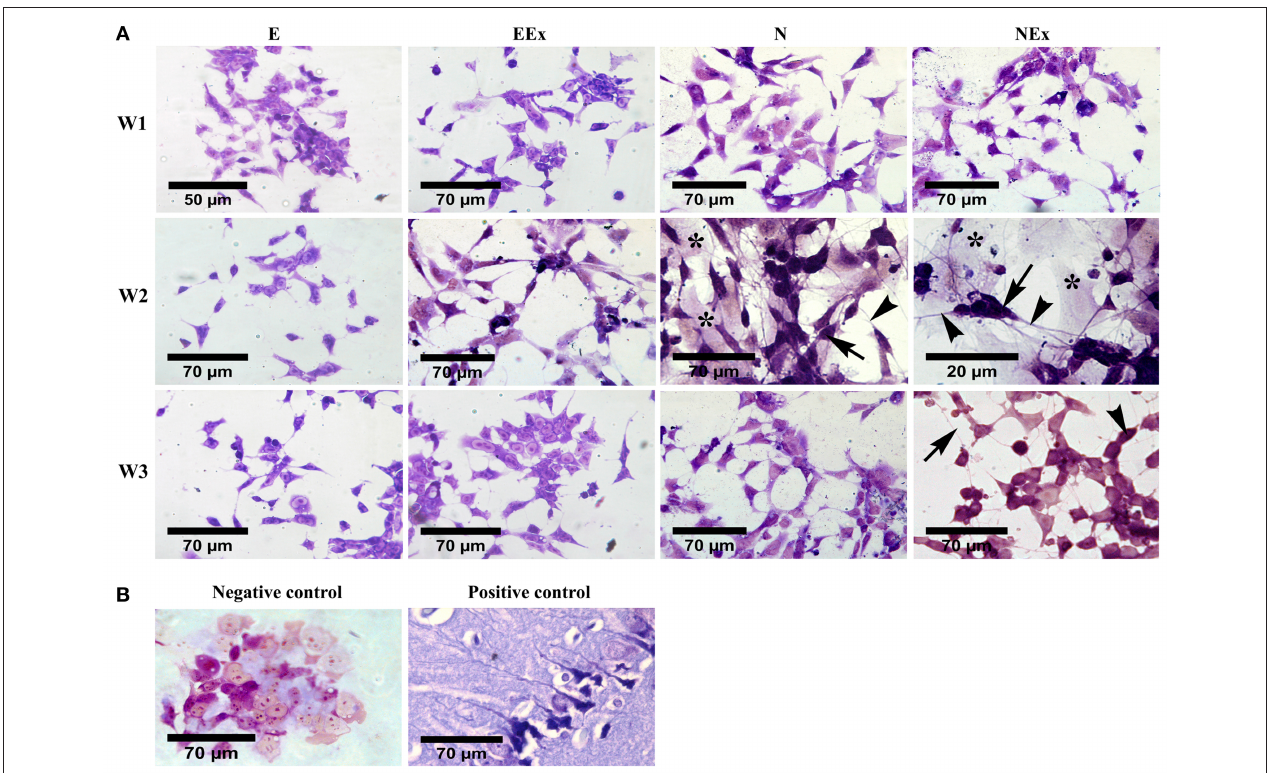
FIGURE 3 | Evaluation of neural phenotype in the differentiated cells by cresyl violet specific staining. (A) Over a period of 1–3 weeks, the cells in all the experimental groups stained, and purple cells with a small body (arrows) and fine processes (arrowheads) were considered as neuron-like cells. Examination of the cells using a bright-field microscope indicated that the density of the cells with neural phenotype was higher in the second week of the differentiation protocol, while, in the third week, they showed a non-neuronal appearance. The purple cells were interconnected individually or as aggregates via their numerous fine processes to form neuron-like networks on top of a bed of pale cells with a non-neural appearance (asterisks). (B) P19 untreated cells and rat brain tissue were also stained with cresyl violet and presented as negative and positive controls, respectively. E (empty), EBs transfected with pCMV3-GFPSpark vector; EEx (empty/extract), EBs transfected with pCMV3-GFPSpark vector and treated by extract; N (Nurr), EBs transfected with pCMV3-NR4A2-GFPSpark vector; NEx (Nurr/extract), EBs transfected with pCMV3-NR4A2-GFPSpark vector and treated by extract; W1, W2, W3, week 1, 2, 3, respectively.